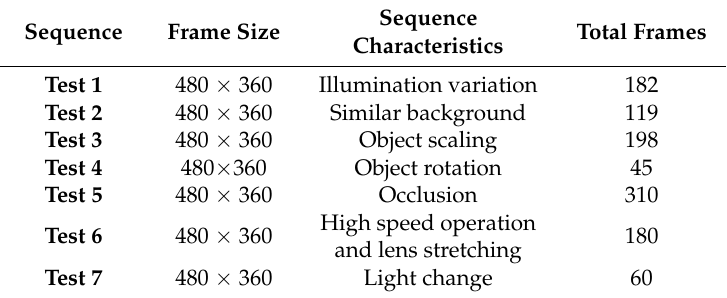
Table 1. Video Sequences Used in Our Experiments.